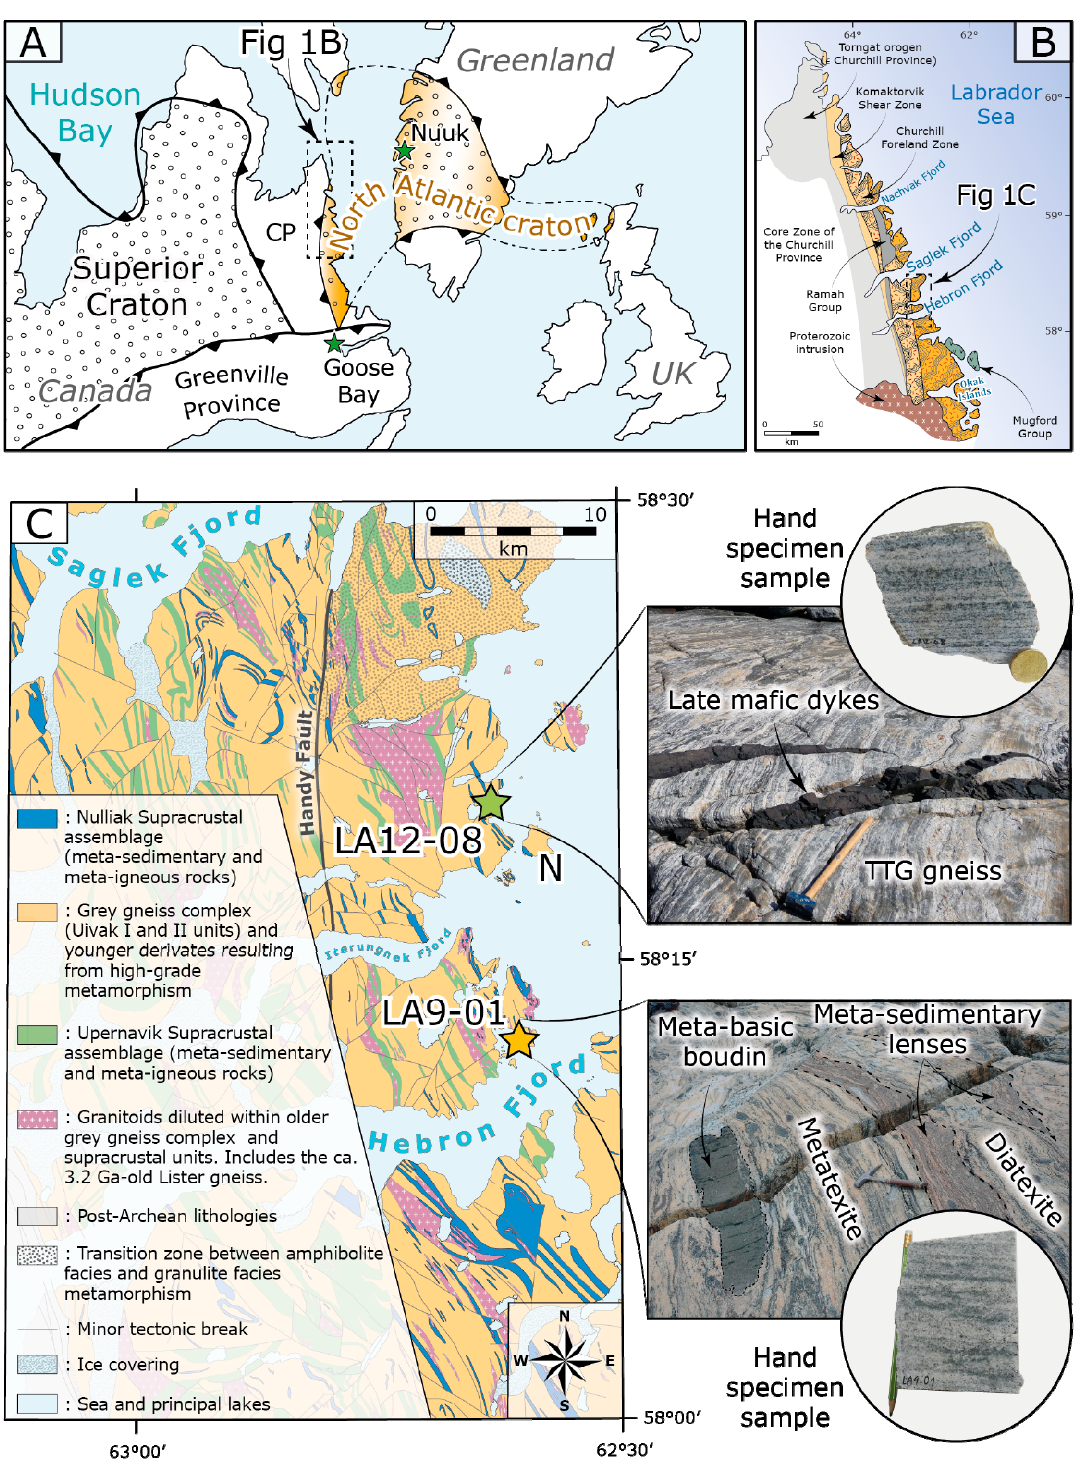
Figure 1. ( A ) Pre-drift reconstruction of the North Atlantic craton (yellow area on the map), dotted areas are pre-2.5 Ga terranes; green stars represent towns. CP: Churchill Province. ( B ) General geolog- ical map of the north-eastern Labrador and Qu é bec modified after [modified after 48]. ( C ) Geological map of the Saglek Block modified after [48], with localization of the sampling sites (green and yellow stars), and a view of the outcrops and hand-specimens investigated in this study. N: Nulliak Island. Star color coding does not refer to